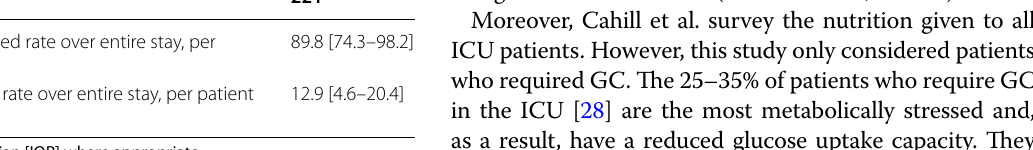
Table 4 Per-patient feed rate characteristics Number of patients